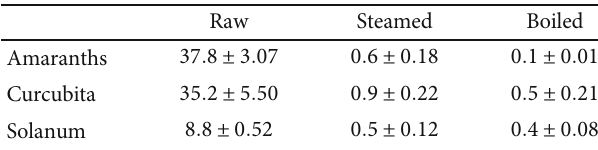
Table 1: Average vitamin C concentration in the raw and cooked vegetables in mg/100g.